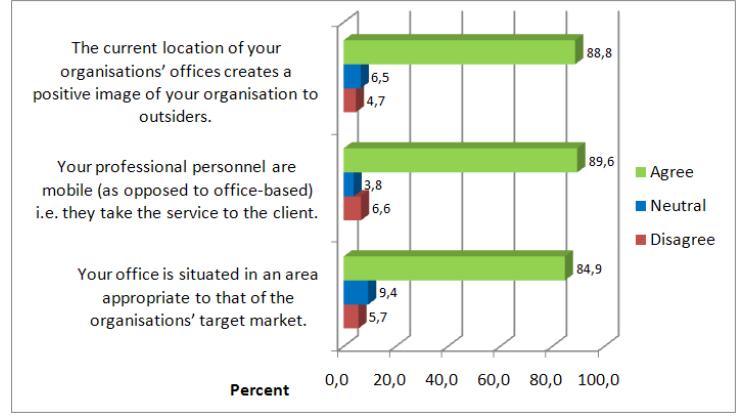
Fig. 5. Respondent scores: place